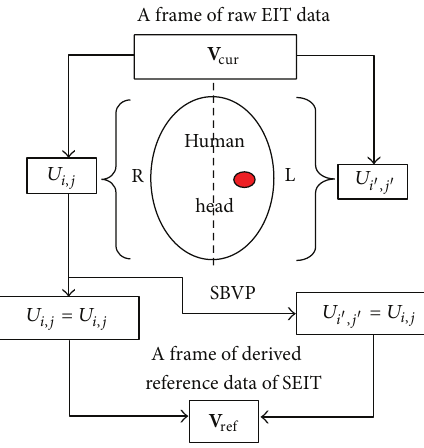
Figure 2: Construction of SEIT reference data. During construc- tion, the raw EIT data measured from the undamaged CCH (e.g., the right CCH) was copied to the contralateral side according to the relationship of SBVP.